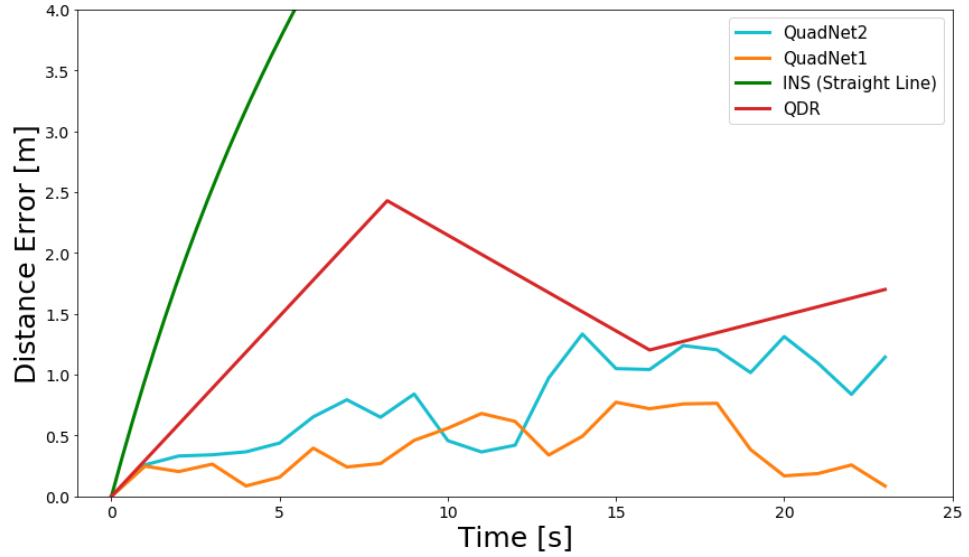
Figure 8. INS, QDR, and QuadNet architectures distance error throughout the periodic motion trajectory #1 using IMU #1.